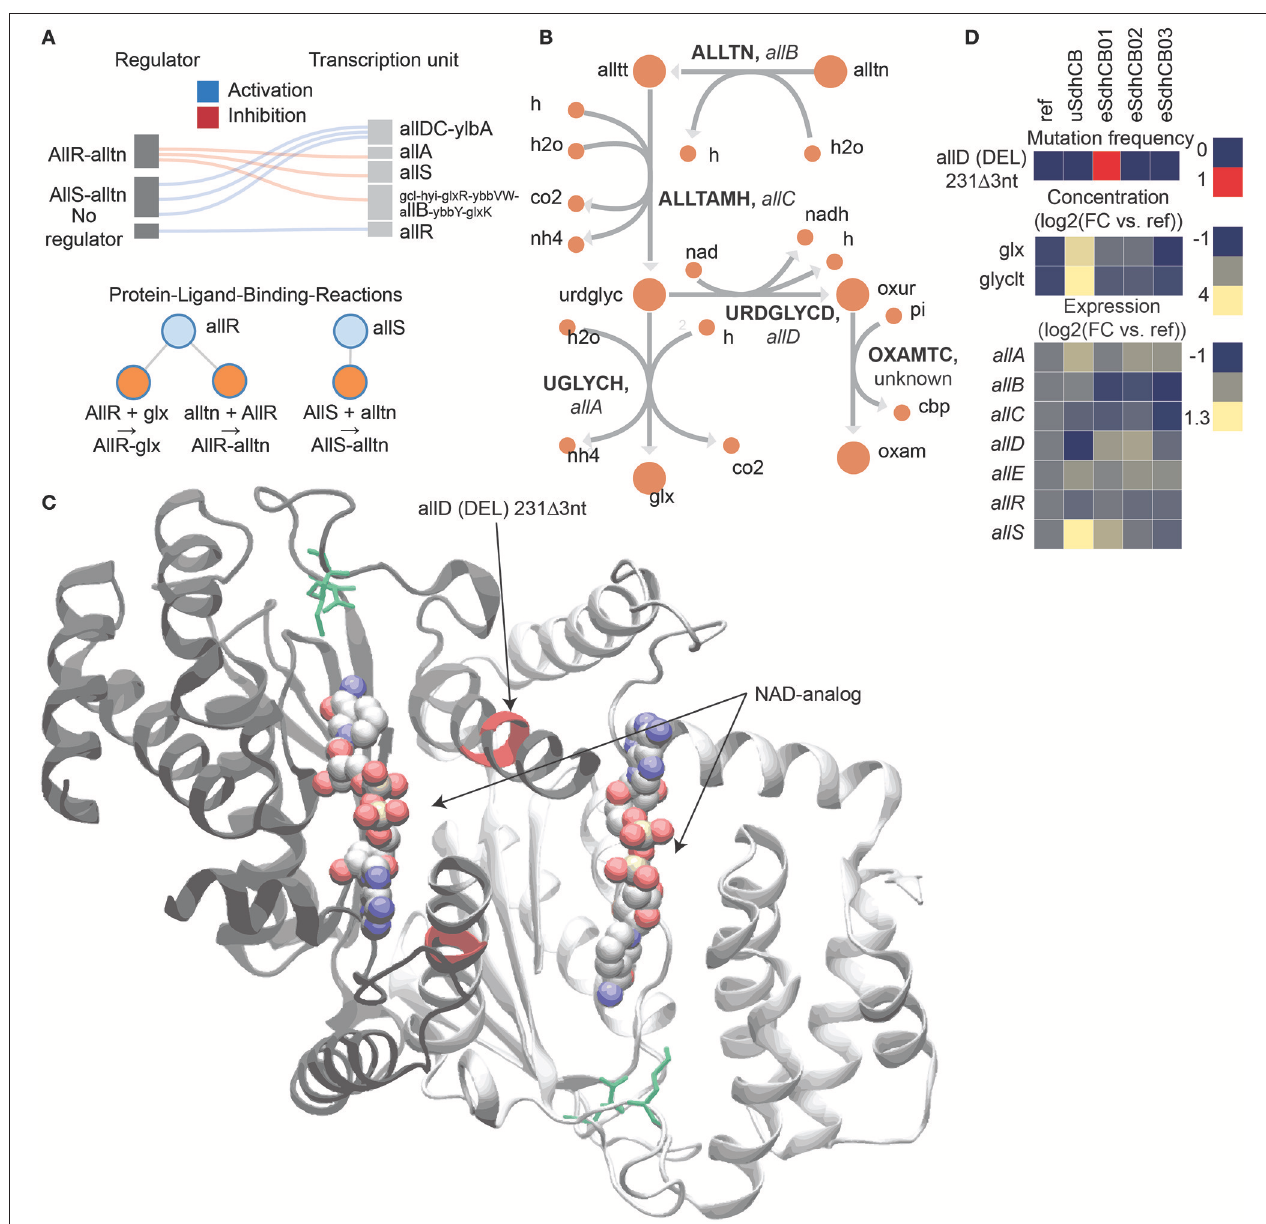
FIGURE 5 | A mutation in the active site of ureidoglycolate dehydrogenase (URDGLYCD) in eSdhCB01 that potentially provided an auxiliary means to metabolize excess glyoxylate (glx) and/or balance nitrogen levels. (A) Regulatory diagram and protein-ligand-binding reactions. The allDCE operon is positively regulated by AllS, whose gene expression is negatively regulated by AllR (Rintoul et al., 2002). allA and allB are also negatively regulated by AllR (Rintoul et al., 2002). Glyoxylate enzymatically inhibits AllR repression of allS , allA , and allB (Rintoul et al., 2002). (B) Network diagram of allantoin assimilation. (C) Crystal structure of AllD. Mutations are highlighted in red. Active site residues are highlighted in green. An NAD-analog where NAD would bind is shown. Note that the deletion (DEL) mutation in eSdhCB01 would affect active site residues, and most likely binding of NAD and other substrates. (D) Mutation frequency, metabolite levels, and gene expression of components involved in allantoin assimilation. Note that gene expression profiles are consistent with high glyoxylate levels in